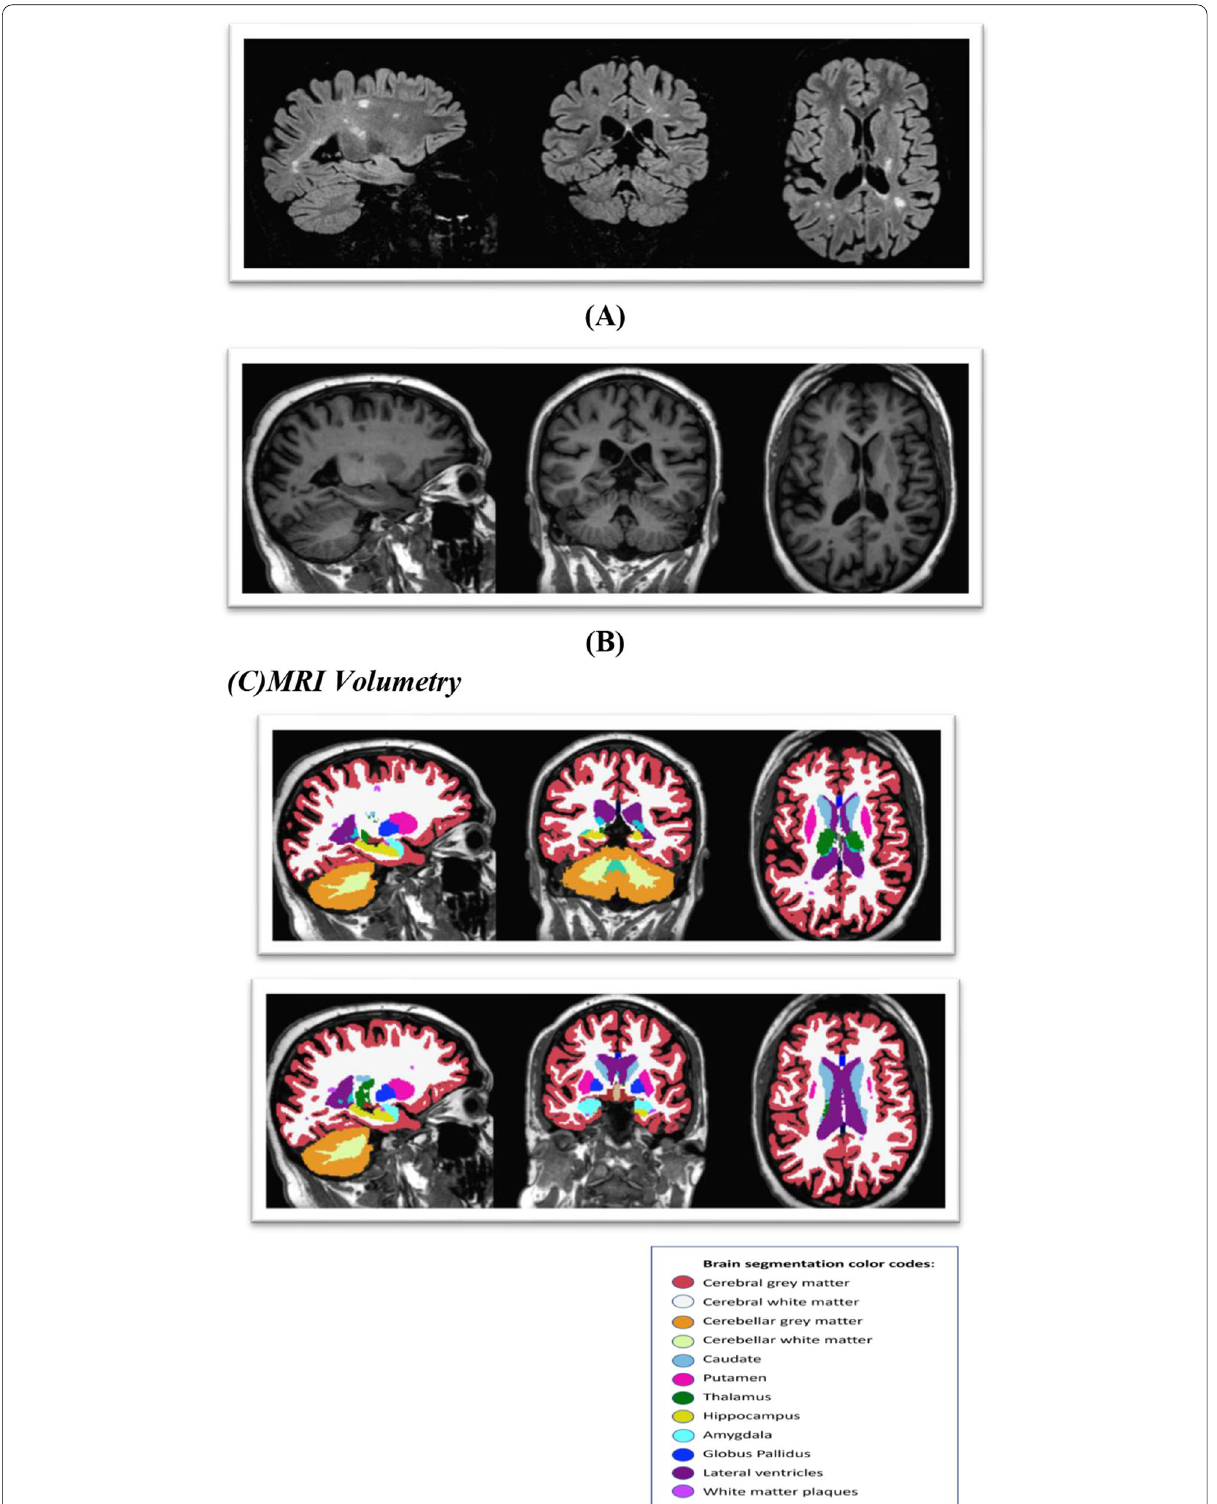
Fig. 14 24 year old female diagnosed with MS 3years ago with EDSS (1) and no cognitive impairment. ( A ) 3D FLAIR images showing multiple foci and patchy areas of high signal intensity implicating the peri ventricular and juxta cortical white matter. ( B ) 3D T1 images showing multiple foci and patchy areas of slightly low signal intensity implicating the peri ventricular and juxta cortical white matter. ( C ) MR